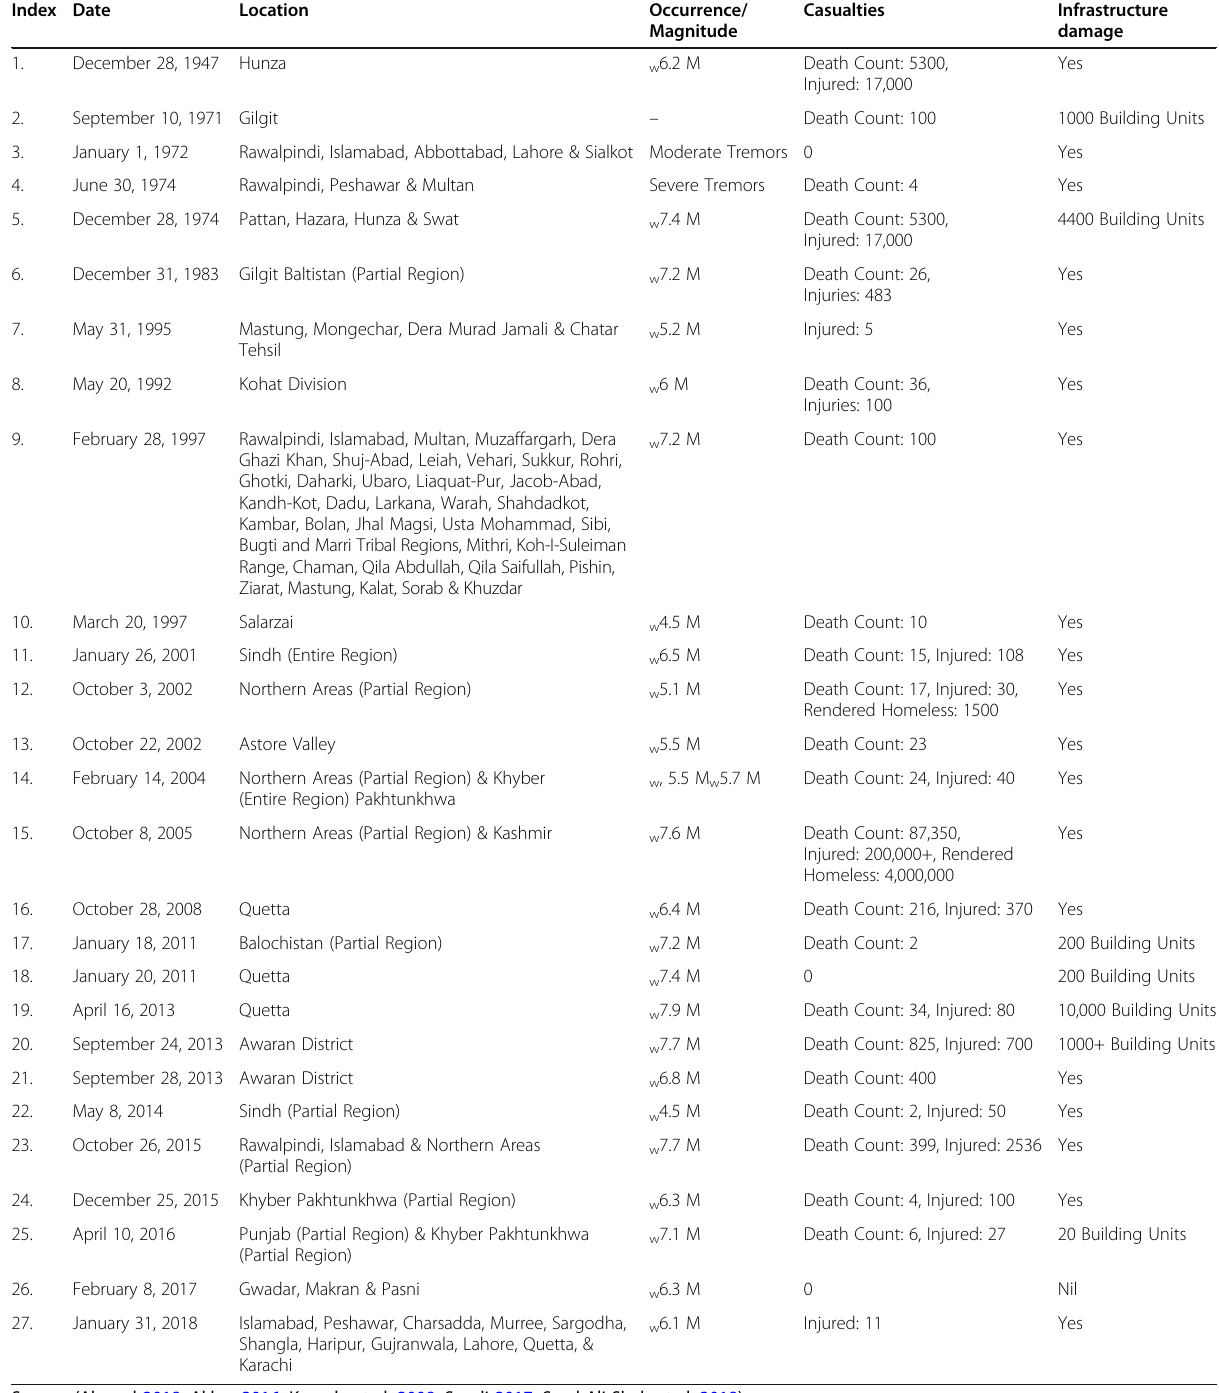
Table 1 Major seismic activity timeline of